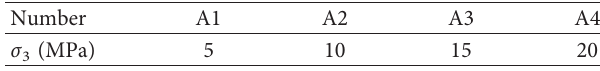
Figure 3: Loading of triaxial compression test. Table 1: Conventional triaxial compression test scheme.